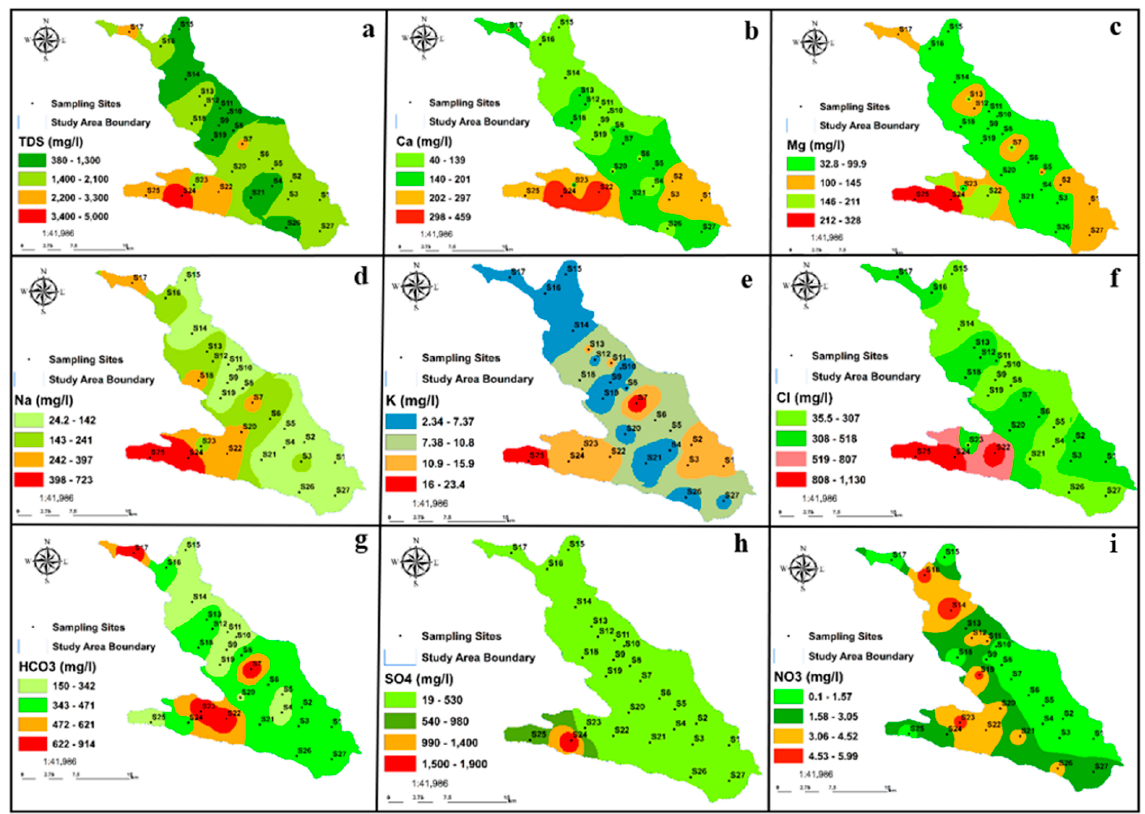
Figure 8. Distribution map of the physicochemical parameters: ( a ) TDS, ( b ) Ca 2+ , ( c ) Mg 2+ , ( d ) Na + , ( e ) K + , ( f ) Cl − , ( g ) HCO 3 − , ( h ) SO 42 − , and ( i ) NO 3 −